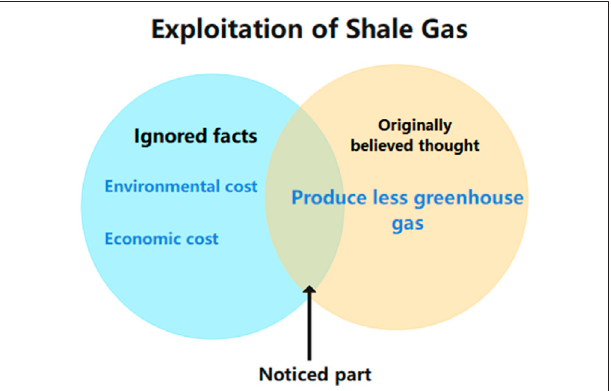
FIGURE 2 | Cognitive biases —— Con fi rmation